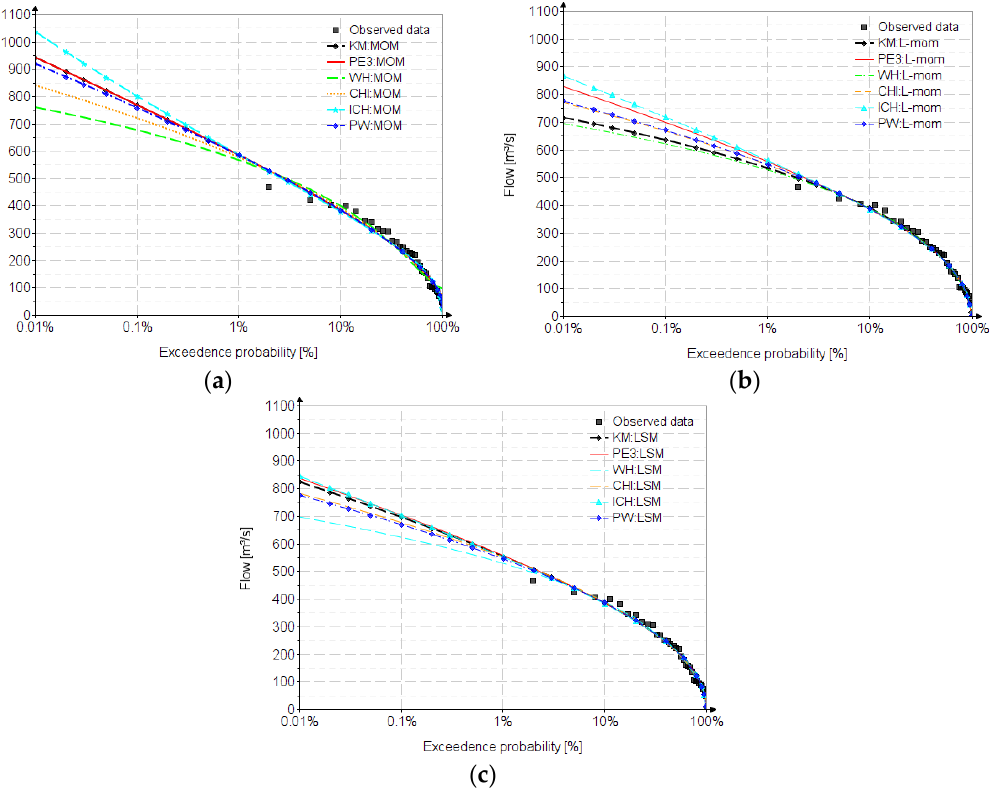
Figure 6. Fitting distributions. ( a ) Kritsky–Menkel; ( b ) Pearson III; ( c ) Wilson–Hilferty; ( d ) chi; ( e ) inverse chi; ( f ) pseudo-Weibull.